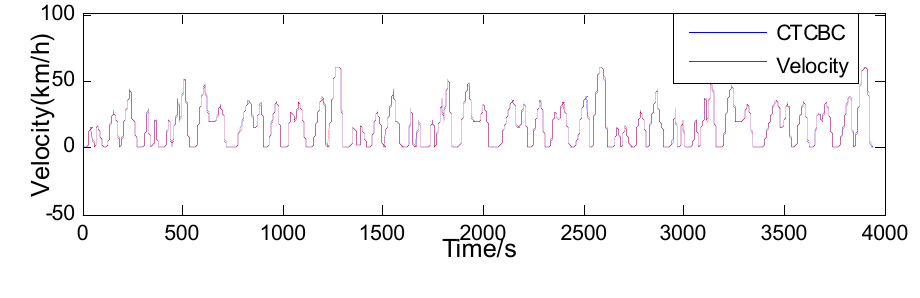
Figure 14. The velocity following curve.